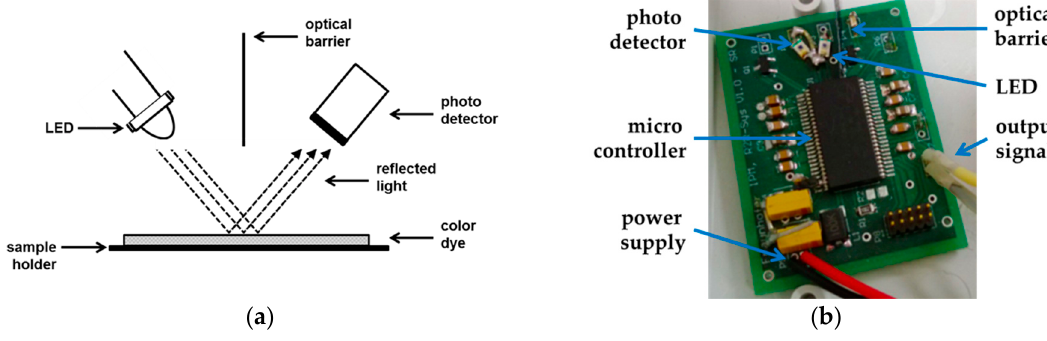
Figure 1. ( a ) Sketch of the measuring principle. The color change of the sensitive probe can be detected by the reflected light of a blue LED on the surface of the color dye. To avoid interfering light, an optical barrier is mounted between the LED and the detector; ( b ) Picture of the realized measurement system. The measuring board is fixed towards the sensitive probe.